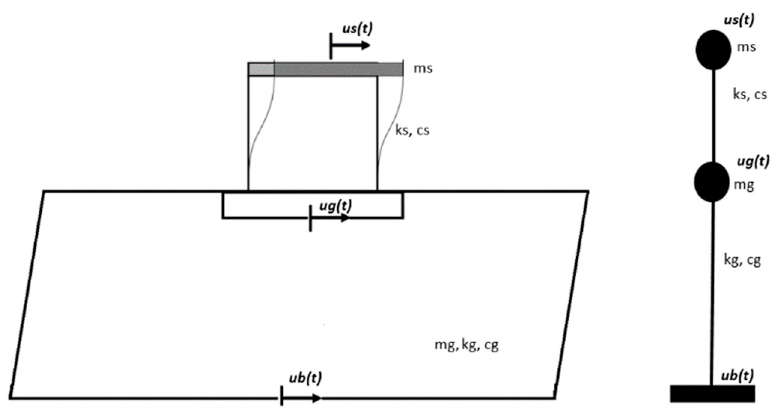
Figure 1. Schematic two degrees of freedom (2-DOF) model.